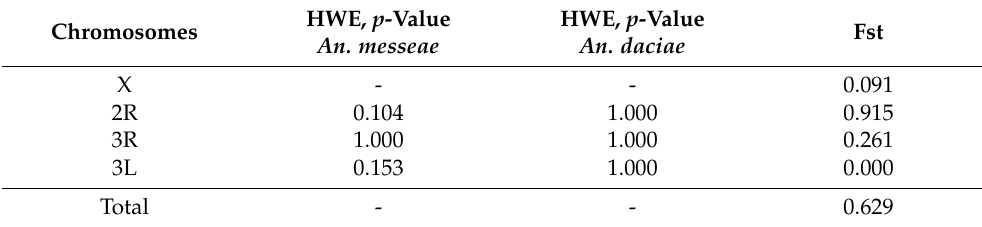
Table 4. Results of the exact test for Hardy-Weinberg Equilibrium (HWE) and analysis of population differentiation